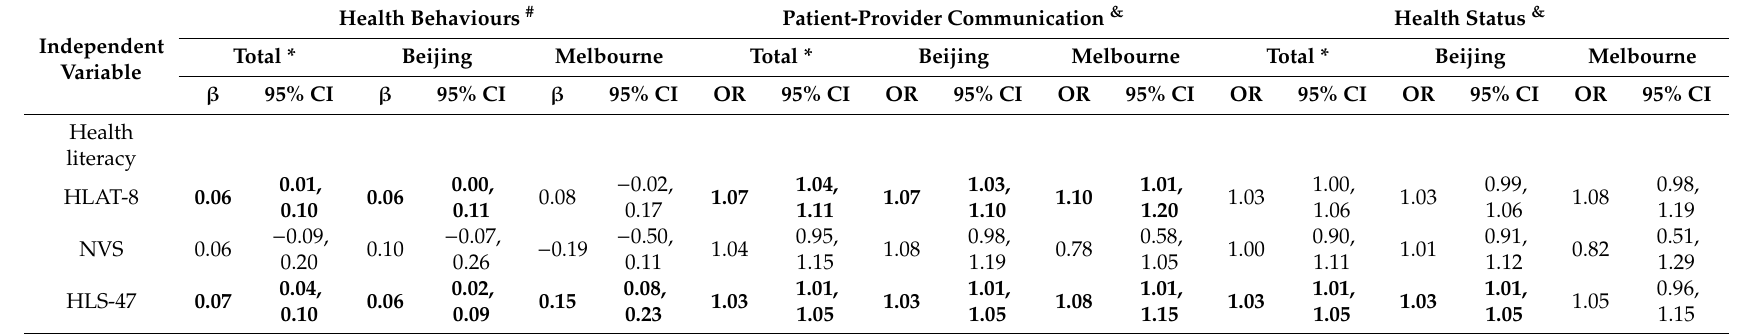
Table 4. Multivariate regression models predicting health outcomes according to di ff erent